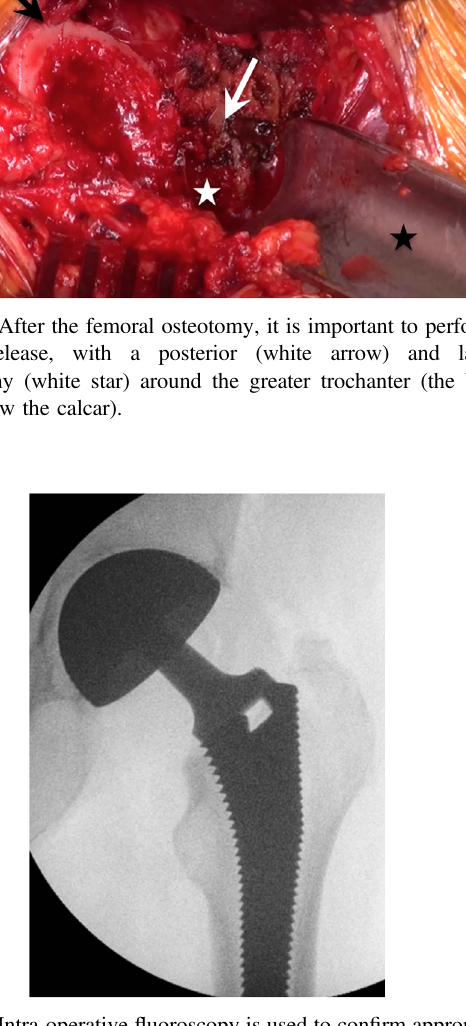
Figure 7. Intra-operative fl uoroscopy is used to con fi rm appropriate positioning of implants.